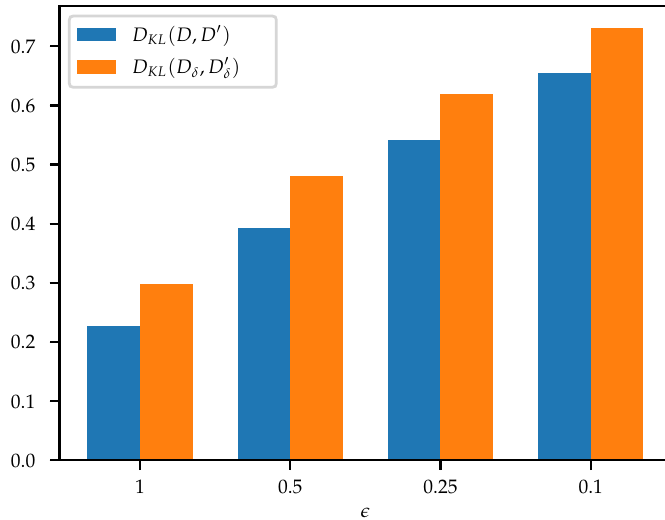
Figure 3. K-L divergence under different privacy budget